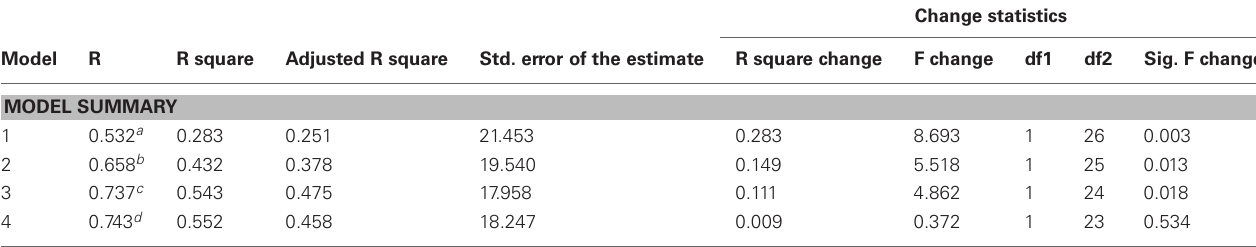
Table 3 | Results of multiple regression models examining relationships between individual variation in theta attentional activation in midfrontal right sites and individual variation in cortisol reactivity and boredom increase in relation to the attention